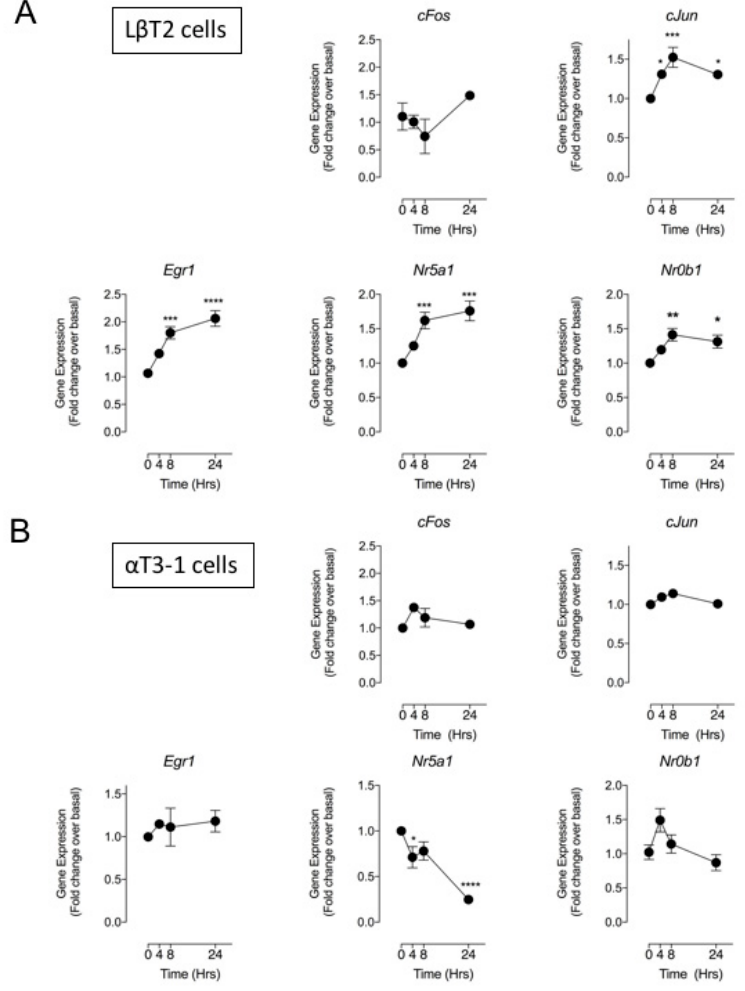
Figure 5. Effect of CNP on gonadotrope transcription factor gene expression in L β T2 and α T3-1 cells. L β T2 ( A ) and α T3-1 ( B ) cells were stimulated with 0 or 100 nM CNP for 0, 4, 8, and 24 h, before extracting RNA and performing multiplex RT-qPCR for gonadotrope transcription factors. Data